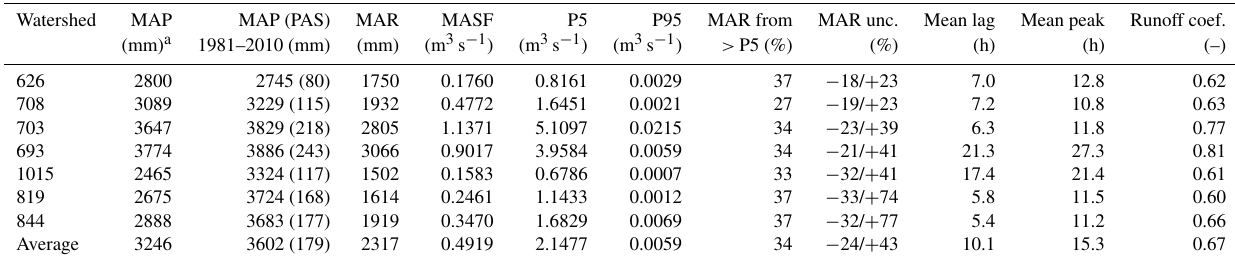
Table 4. Hydrometeorological characteristics of the seven gauged watersheds. Shown are mean annual total precipitation (MAP) a , runoff (MAR), and streamflow (MASF) averaged over the water years with complete precipitation station records (October 2015–October 2019). Additional metrics include the flow duration exceedance probabilities for low (P95) and high (P5) flows, the percent of annual runoff originating from > P5 events, the percent of uncertainty in annual runoff, the mean lag and peak times (time from peak rain to start of rise in hydrograph and start of rise in hydrograph to peak discharge, respectively) b , and the runoff coefficient (MAR/MAP). Total precipitation was averaged over the records of the stations located inside and at the border of each watershed. Averages for watersheds 693 and 703 also include measurements from East Buxton, which is located outside the watershed boundaries but close enough to be representative of the watersheds’ high elevation areas. Climate normals (1981–2010) for precipitation with precipitation as snow (PAS) were calculated by averaging station-specific, modelled ClimateNA data (Wang et al., 2016).